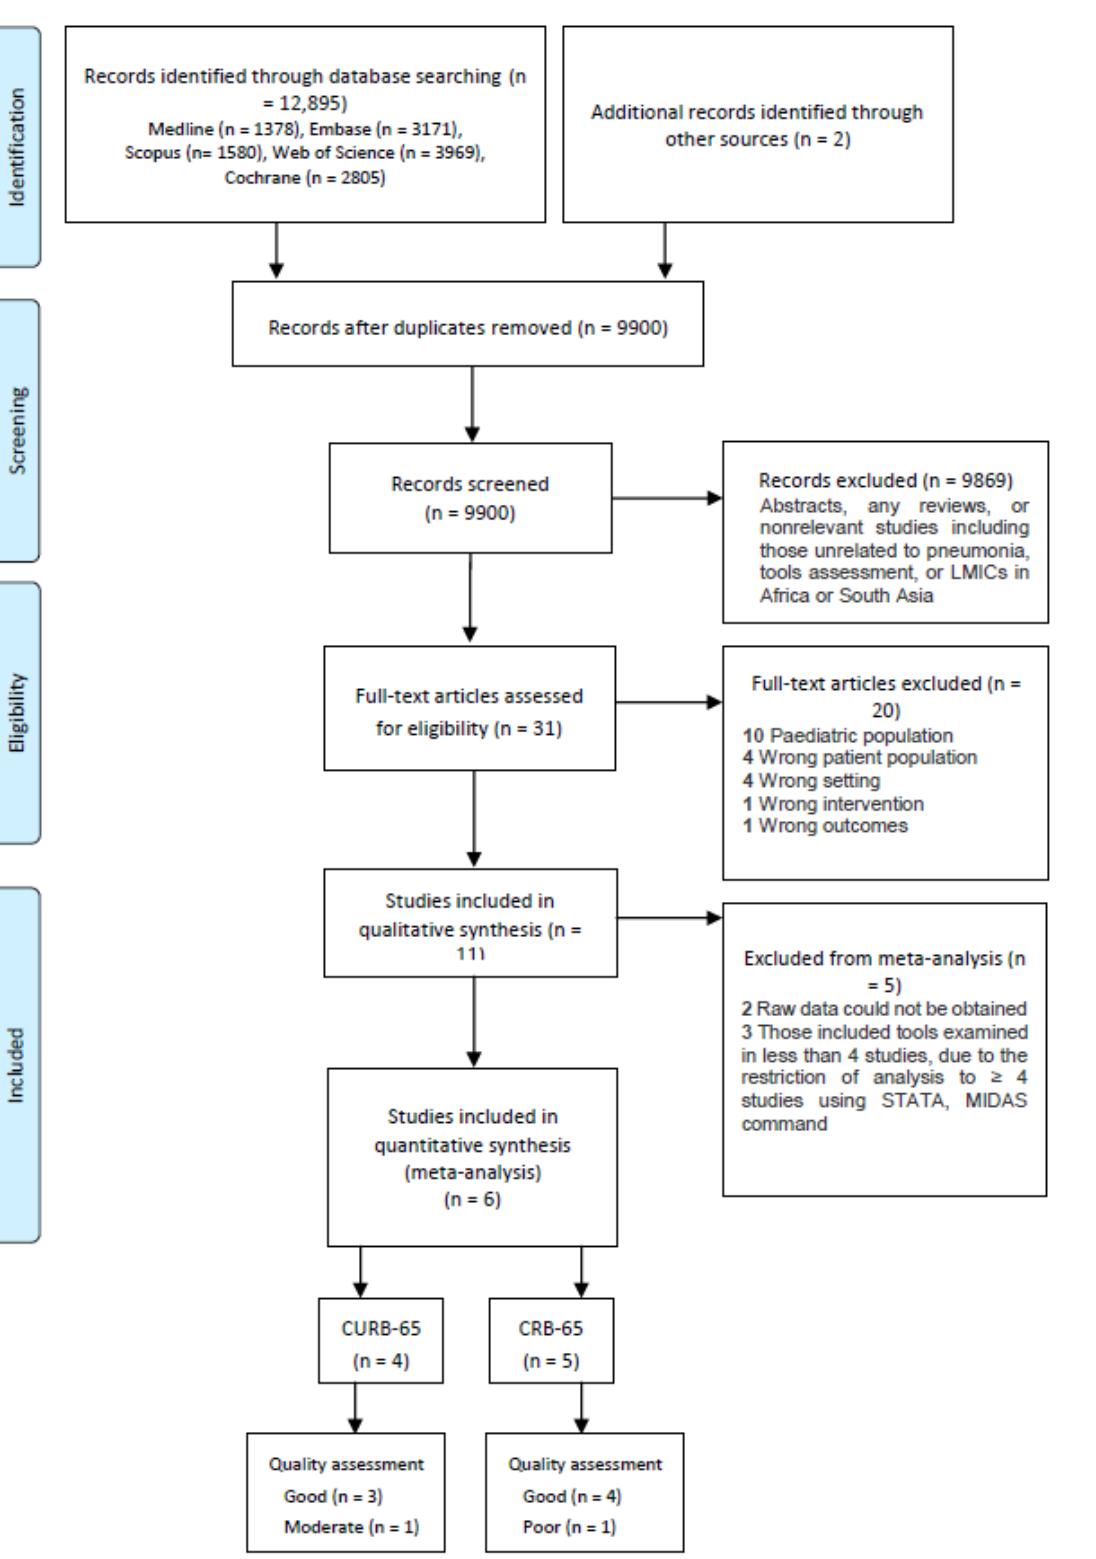
Figure 1. PRISMA flow diagram for the study selection process.